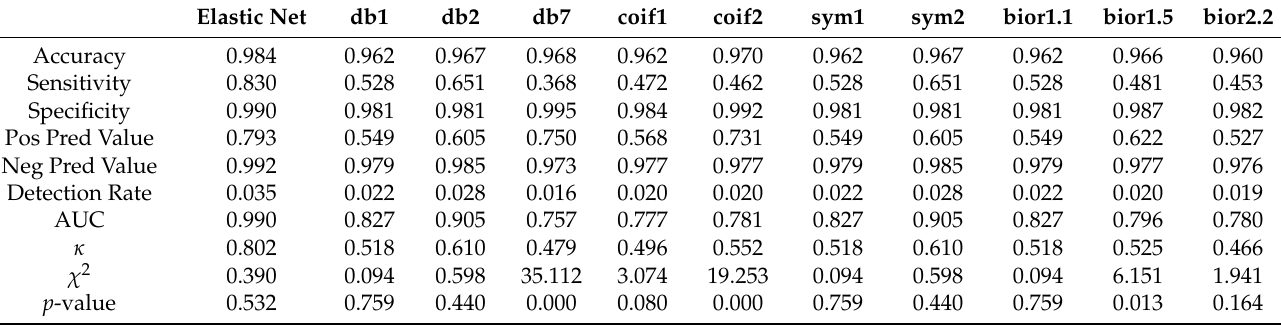
Table 1. Summary of reconstruction of pattern presented in Figure